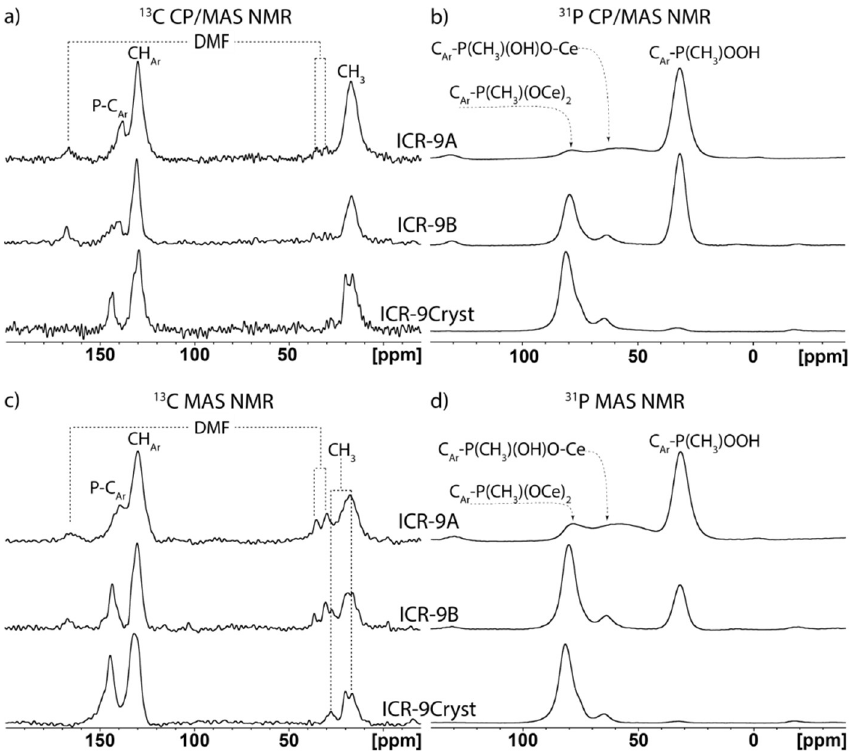
Figure 6. 13 C and 31 P solid state NMR (ssNMR) spectra of ICR-9Cryst, ICR-9B, and ICR-9A: ( a ) 13 C cross-polarization magic angle spinning (CP/MAS) NMR; ( b ) 31 P CP/MAS NMR; ( c ) 13 C MAS NMR; ( d ) 31 P MAS NMR experiments.